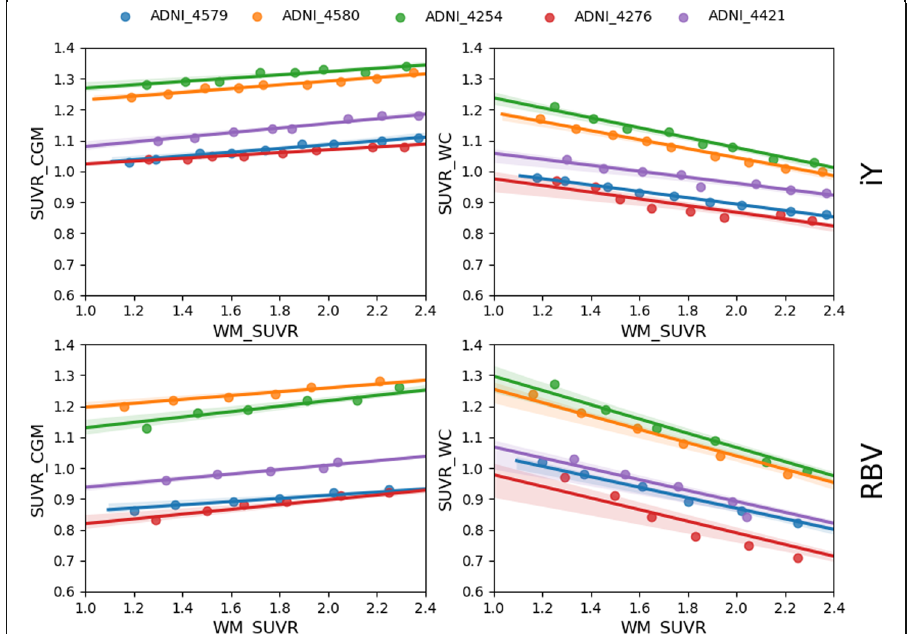
Fig. 6 Relation between the measured SUVRs and WM-SUVR CGM for PVC corrected images. Each color represents one of the simulated patients. Values are represented for SUVR CGM (left) and SUVR WC (right) and for iY (top) and RBV (bottom)